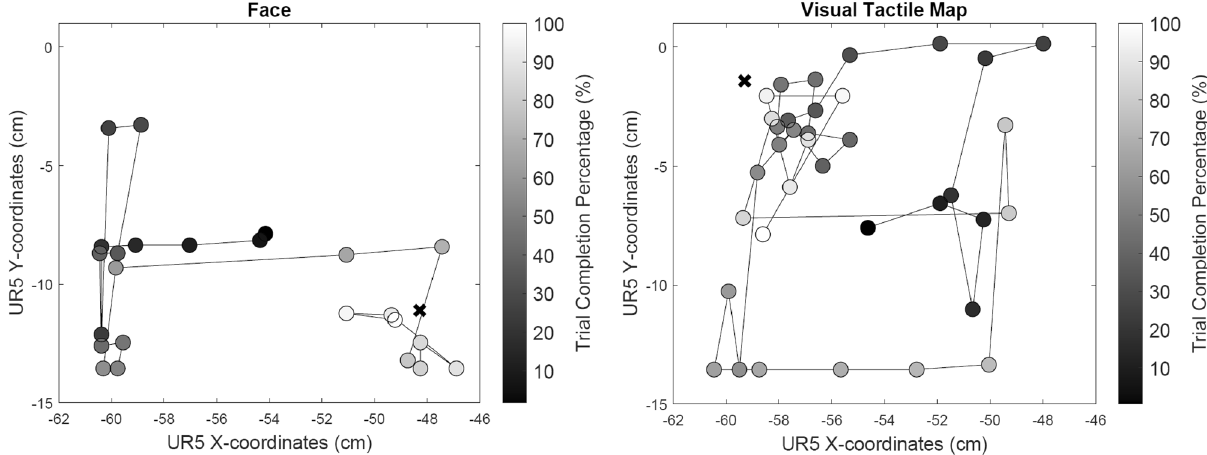
Figure 4. Exploration strategy used by one participant to estimate the location of a hard nodule in two feedback conditions. Left: when presented with face mediated approach; Right: when presented with visual tactile map feedback. Actual location of the hard nodule in respective trials is marked as a cross. Each filled scatter circle represents a palpation point and lines show the palpation path from start to end. Palpation points are color- coded according to the trial completion percentage (see color bar on right). MATLAB 2020a (https:// www. mathw orks. com) is used to generate the